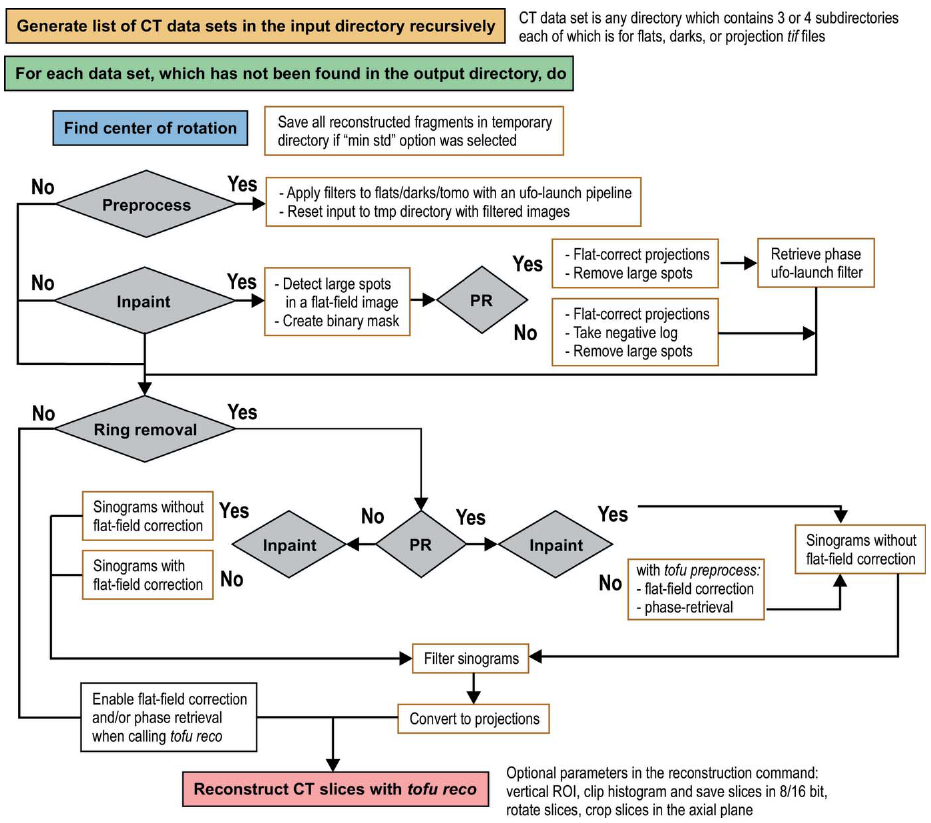
Figure 5 Block diagram of the tofu ez workflow generation. PR stands for phase retrieval; inpaint refers to an algorithm which removes large spots stemming from scintillator